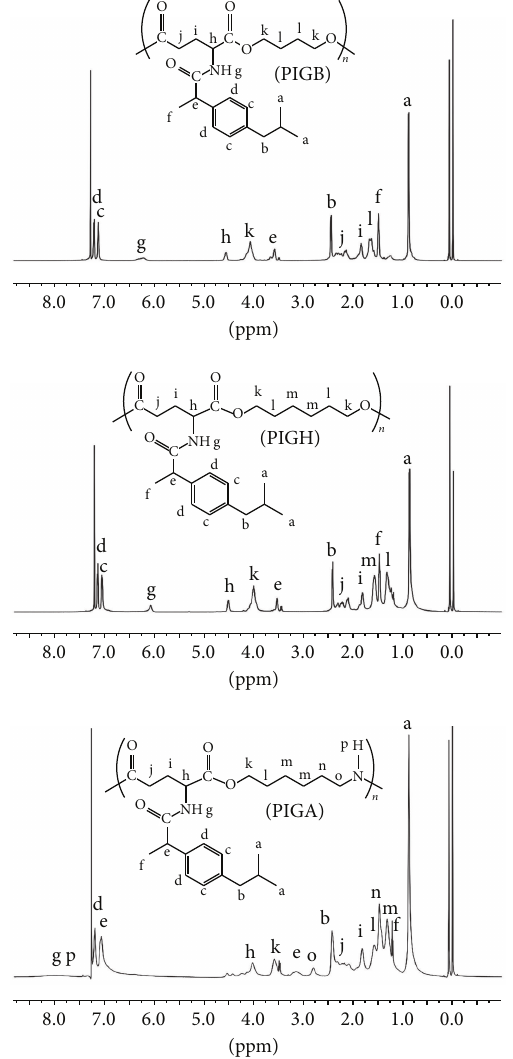
Figure 3: 1 H NMR spectra of PIGB, PIGH, and